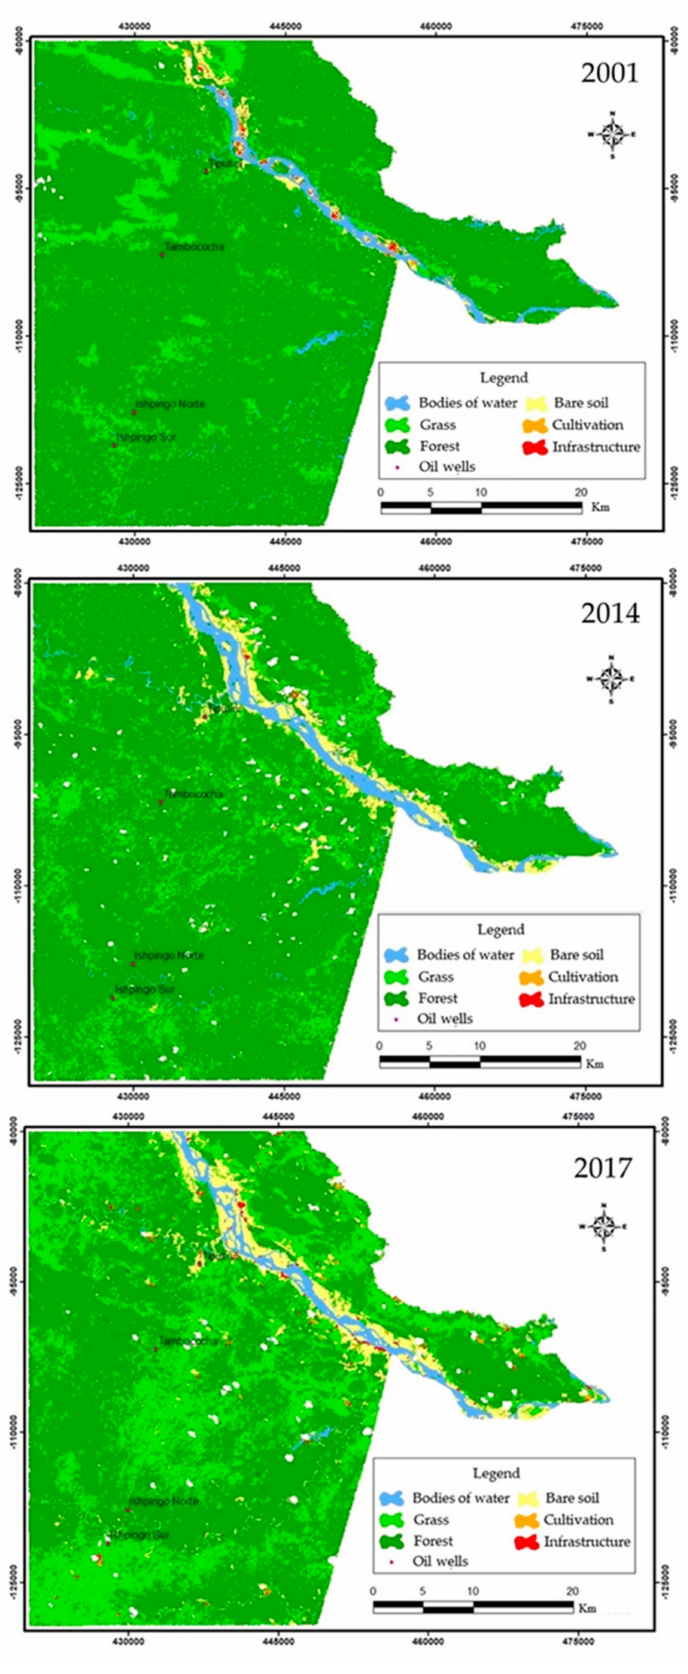
Figure 5. Classification of land-use changes in the ITT Oil Block of the Ecuadorian Amazon region in the years 2001 (upper part), 2014 (center), and 2017 (lower